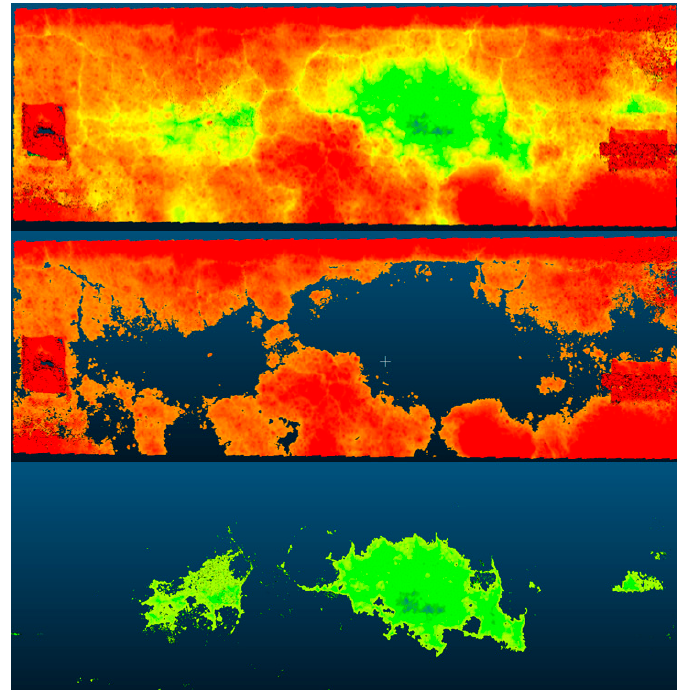
Figure 29. Segmented pavement section 1 using fit plane.